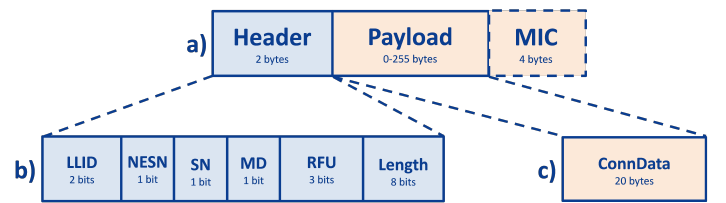
Figure 11. PDU structure of a BLE connection packet. In ( a ) the first two bytes represent the Header, while the other bytes are the effective payload of the packet; in addition to this there are four optional bytes at the end, existing only in LL encrypted connections, which are the MIC. The Header, showed in detail in ( b ), is composed of 2 bits of LLID, 1 bit of NESN, 1 bit of SN, 1 bit of MD, 3 bits of RFU and 8 bits of Length. Then, in the case of BLE connection packets, only 20 bytes of the remaining 255 of payload are filled, and these bytes represent the ConnData, as shown in ( c ).